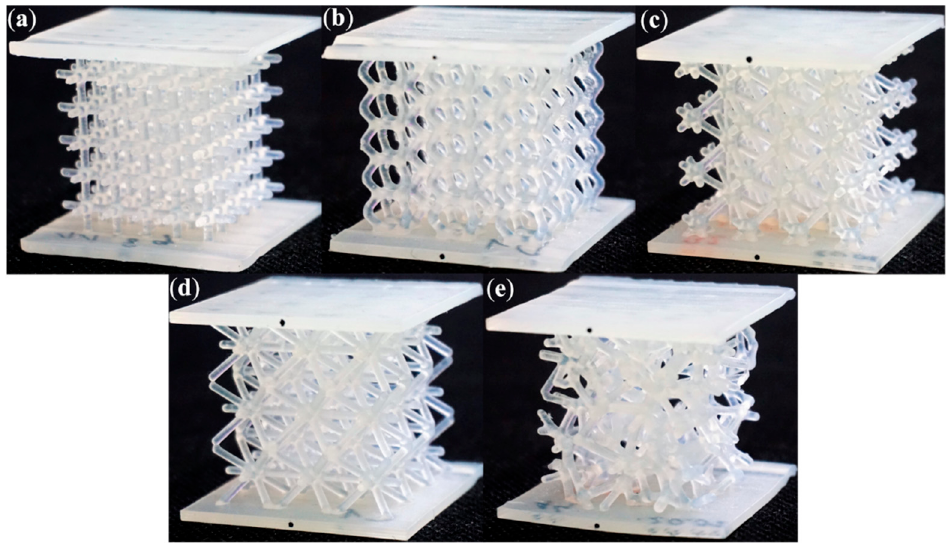
Figure 2. Photographs of the printed structures: ( a ) Grid; ( b ) Hexagon; ( c ) Star; ( d ) Tetra; ( e ) Trabecular.